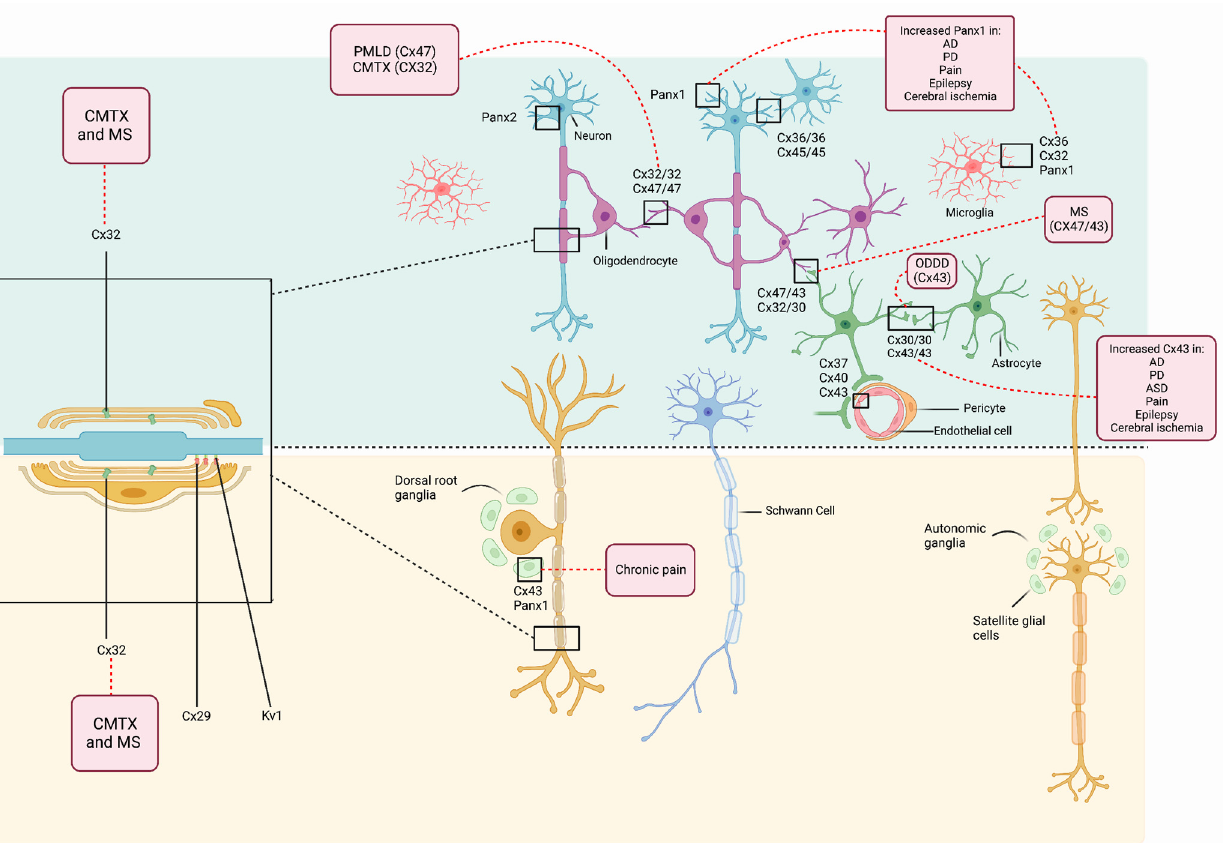
Figure 4. Expression of Cxs and Panxs in the CNS and PNS, and related diseases. In the upper figure the distribution of Cxs and Panxs can be seen along the CNS. Oligodendrocytes communicate with other oligodendrocytes via homotypic gap junctions mainly formed by Cx47/Cx47 and by Cx32/Cx32 [94]. Cx43 and Cx30 are expressed in astrocytes, and they allow the formation of highly interconnected astrocytes that give rise to the astroglial network; they are also expressed in astrocytic endfoot processes that contact cerebral vasculature. Astrocytes communicate with other astro- cytes via homotypic gap junctions formed by Cx30/Cx30 or by Cx43/Cx43. With astrogliosis, astro- cytes undergo morphological and functional changes that include the increased activation of Cx43 hemichannels involved with the release of neurotoxic compounds. This alteration has been related with AD, PD, ASD, Pain, Epilepsy, and Cerebral Ischemia [123]. Activated microglia have also been related with the release of neurotoxic compounds, and they express Cx36, Cx32, and Panx1 that can be induced by TNF-a and INF-b [105,124]. Inherited diseases have been related to mutations in the Cx genes: ODDD is caused by mutations in GJA1 gene that codes for Cx43 [125] mutations in the GJB1 gene that codes for Cx 32 expressed in Schwann Cells (shown in the lower part of the figure, PNS) and oligodendrocytes results in X-linked Charcot-Marie-Tooth Disease; PMLD is caused by mutations in the GJC2 that codes for Cx47. AD: Alzheimer’s disease, PD: Parkinson’s disease, CMTX: X-linked Charcot-Marie-Tooth disease, MS: multiple sclerosis, PMLD: Pelizaeus–Merzbacher-like disease type 1, ODDD: Oculodentodigital dysplasia, CNS: central nervous system, PNS: peripheral